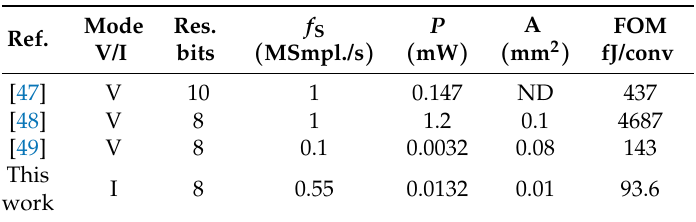
Table 1. Comparison of low power and low chip area SAR